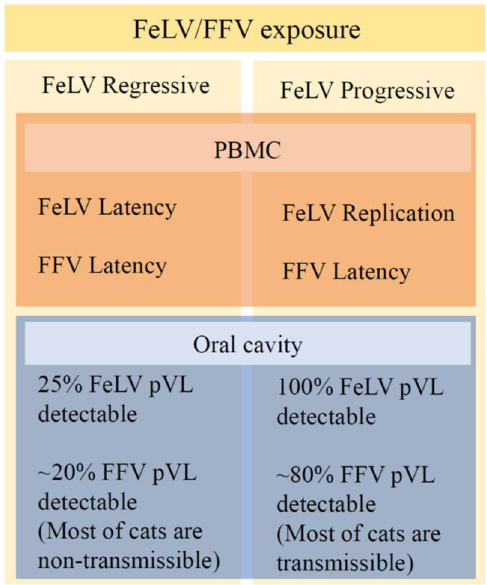
Figure 6. Hypothetical pathway to progressive or regressive outcomes via dual infection with feline foamy virus (FFV) and feline leukaemia virus (FeLV) and potentially active viral replication measured by proviral load (pVL). FeLV progressive and regressive outcome determined by PBMC tissue (blood) pVLs were correlated to different FFV and FeLV pVL patterns of detection in the oral cavity.